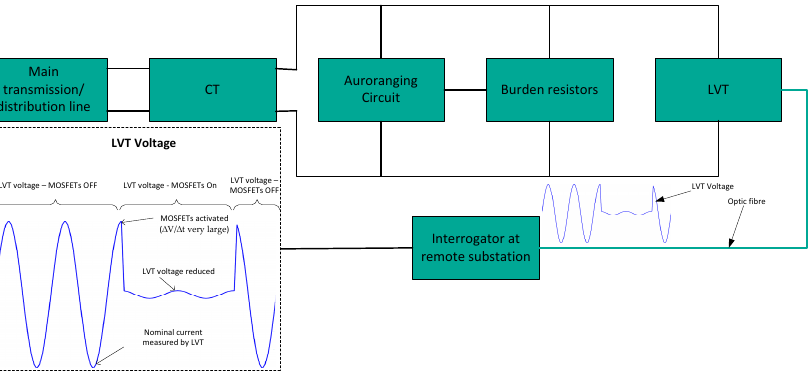
Figure 6. Example of range switching detected by interrogator.